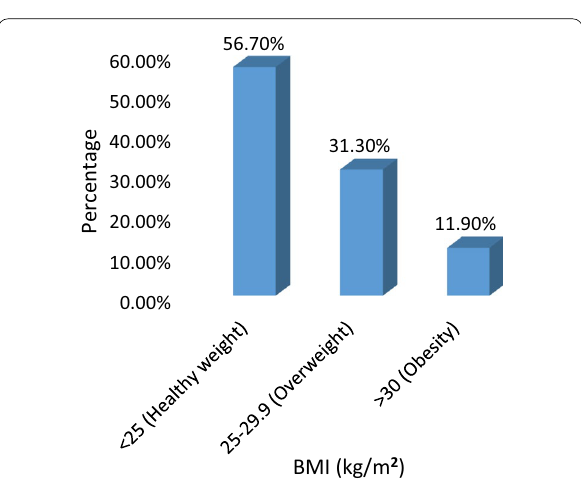
Fig. 2 Distribution of BMI among participants ( n